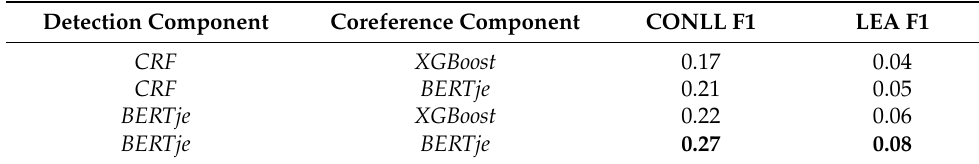
Table 4. Results for the end-to-end pipeline